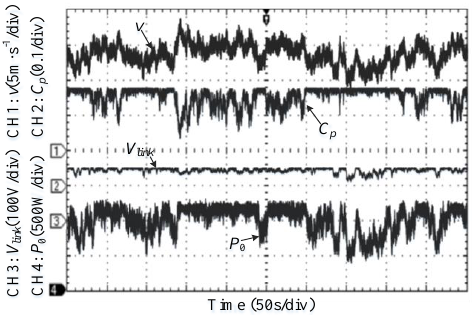
Figure 11. System performances under dynamic wind profile.